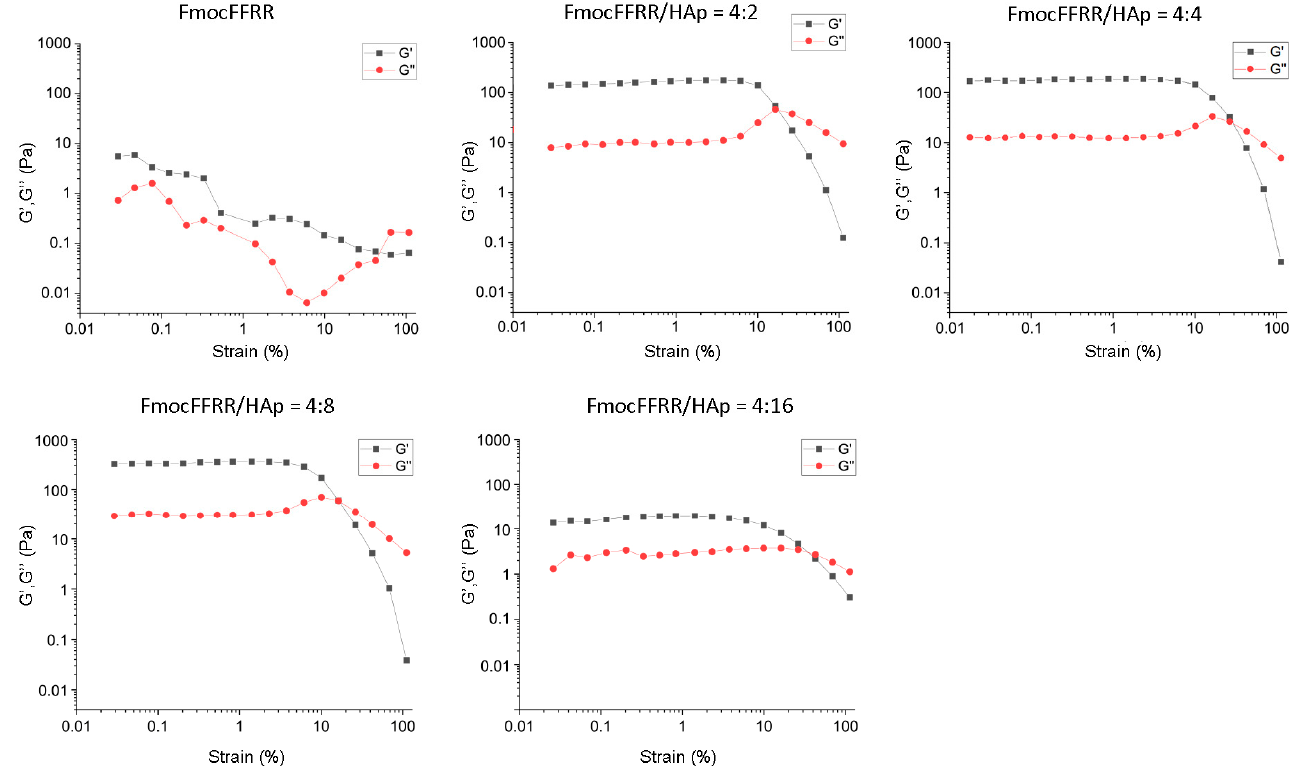
Figure 3. Strain amplitude sweep tests of 4 mg/mL FmocFFRR containing 0, 2, 4, 8, or 16 mg/mL HAp particles at a fixed angular frequency (1.0 rad/s) at room temperature.